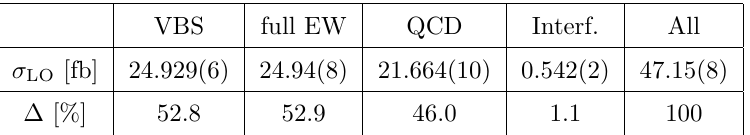
Table 1 . VBS, full EW and QCD cross sections and the EW-QCD interference at LO. The relative contributions are also shown. The full EW and interference cross sections are obtained using Sherpa, while the VBS and the QCD results are from our VBFNLO